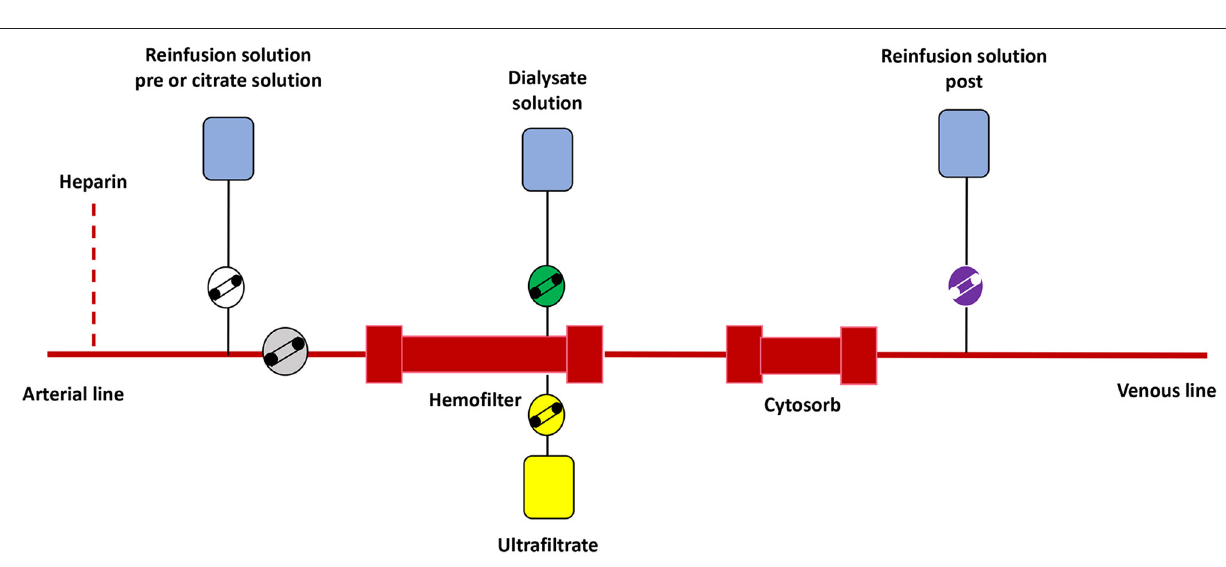
hemofilter was changed every 72 h and the absorber